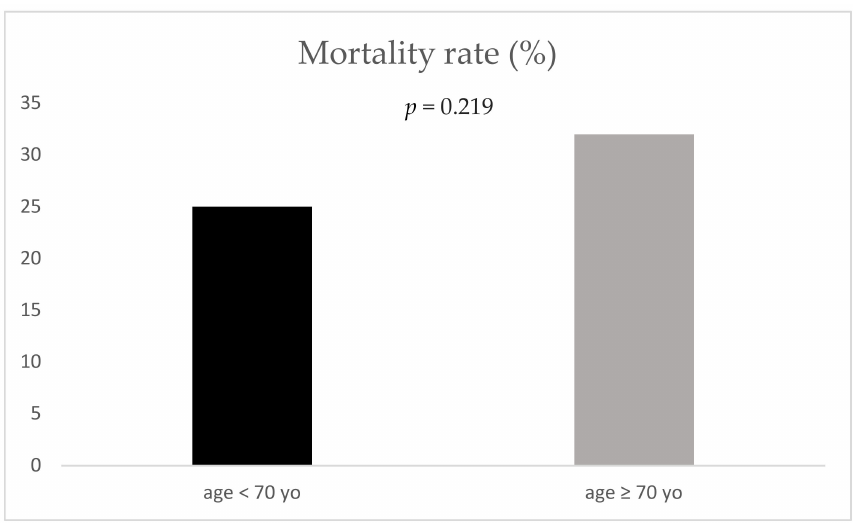
Figure 1. Mortality rate for the two age groups; yo: years